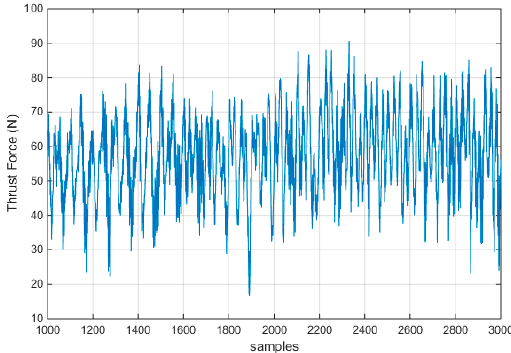
Figure 5. Measured flank wear VB vs. hole number for diverse drilling conditions.